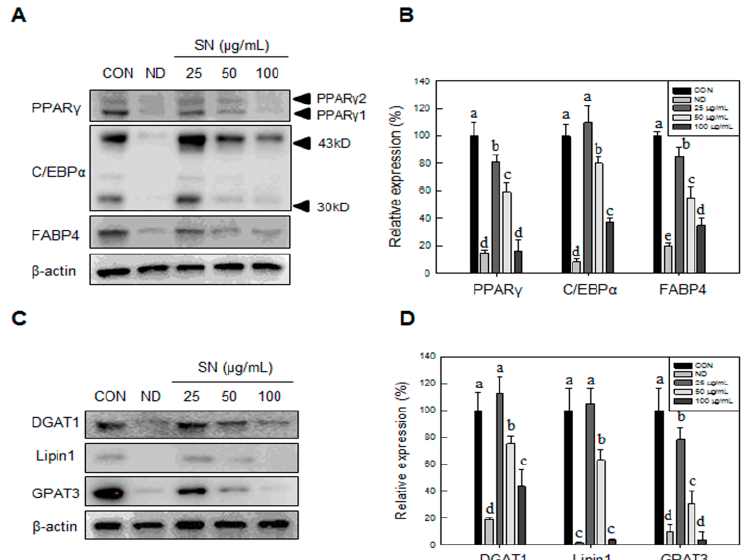
Figure 2. Effects of SN on the expression of adipogenic factors and triglyceride synthetic enzymes in